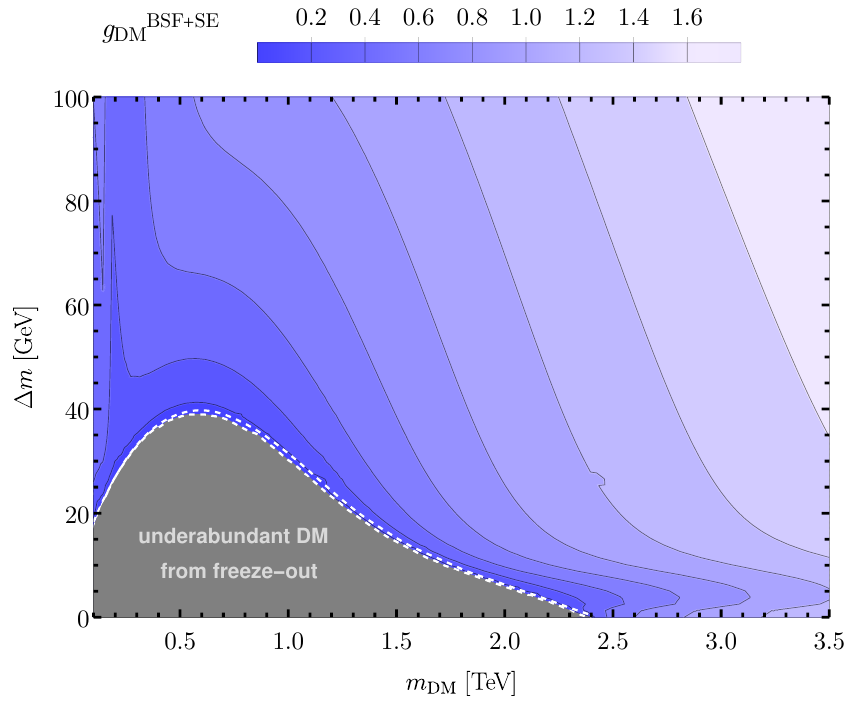
Figure 14. Values of the Yukawa coupling that ensures the correct Ω DM for different mass-splitting ∆ m = m and DM mass combinations. Here, we take into account BSF+Sommerfeld X − M DM processes and, in comparison with figure 5, also include effects of Γ we use Γ 2Γ . The dashed white lines are in correspondence of the region where B→ Xχq ’ X → χq 10 − 7 . g . 10 − 2 . Below this interval, it is not possible to ensure chemical equilibrium between DM the unbound particles in the dark sector and the co-annihilation freeze-out assumption breaks